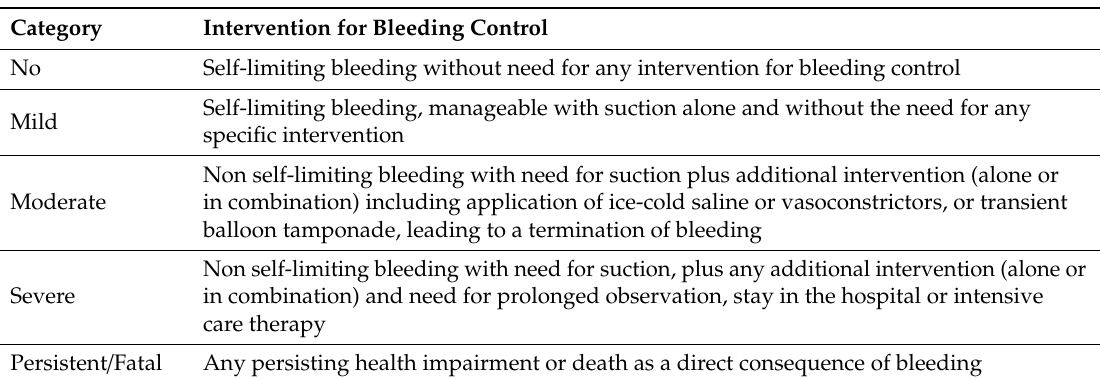
Table 2. Periinterventional